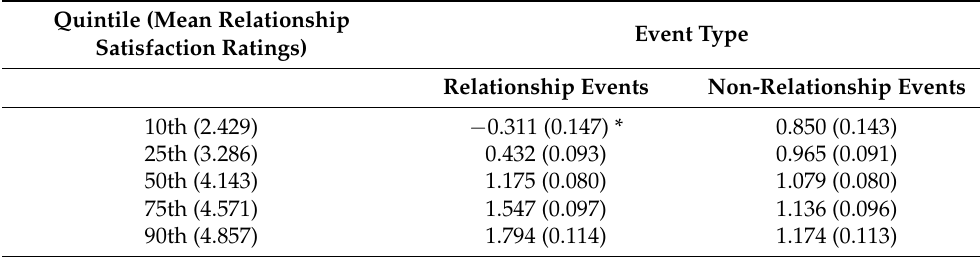
Table 3. Fading Affect Bias Regression Coefficients (SE) for Relationship Events and Non-Relationship Events across Quintiles (Mean Rating) of Relationship Satisfaction Ratings (large positive coefficients represent large FAB).